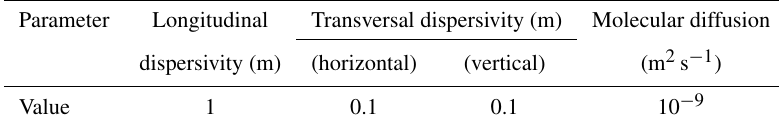
Table 2. Transport parameters.